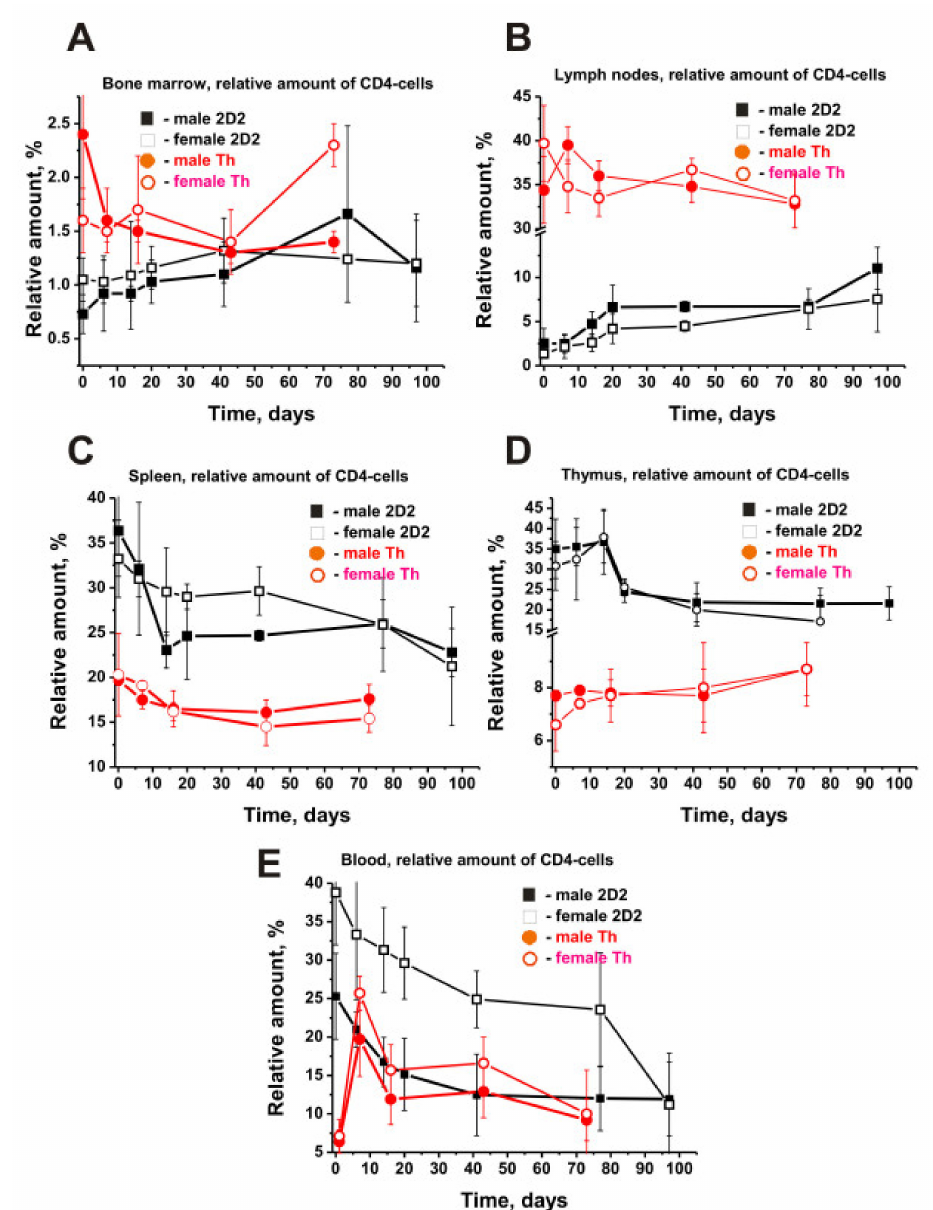
Figure 5. Time-related dependencies in the relative numbers of total CD4 cells in various organs of male and female 2D2 (black symbols) and Th (red symbols) mice. All dependencies for all organs of different males and females are marked in the Figure ( A – E ). For comparison, the data for Th mice were taken from our previously published articles [38,39]. The duration of the experiment and the time of blood sampling for different strains of mice were